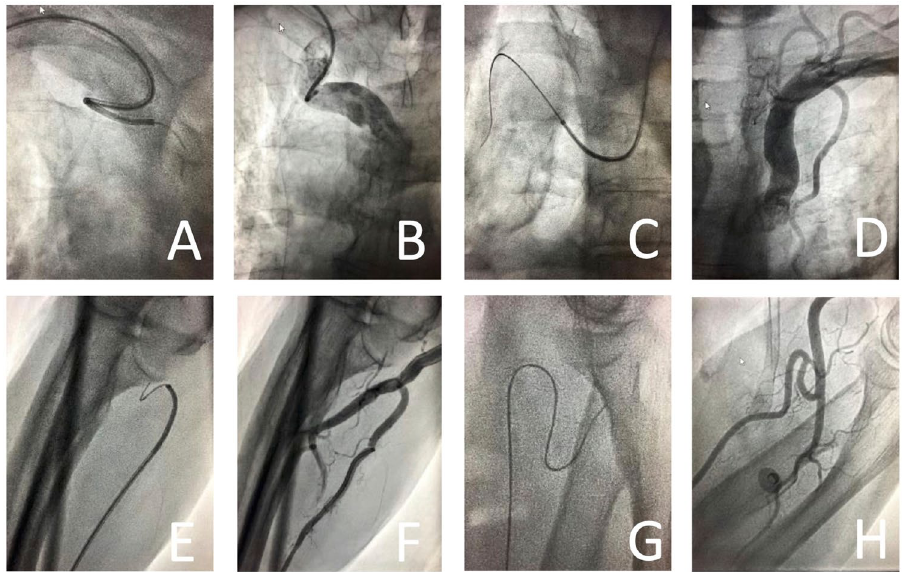
Figure 1. Representative fluoroscopies and angiographies of 2nd degree DVA encountered at our institution within the study period. The figures shown display vascular variants which could not be passed with any of the following guidewires, therefore meeting the definition of 2nd degree DVA: 0.035 ″ J guidewire (Angiodyn, B. Braun), hydrophilic 0.035 ″ guidewire (Radifocus Guidewire M, Terumo) and 0.018 ″ guidewire (Advantage, Terumo). ( A,B ) Severe tortuosity of the innominate artery in a 72-year-old female with suspected CAD. ( C,D ) Aortic arch elongation in a 77-year-old male presenting with NSTEMI. ( E,F ) Right radioulnar loop in a 87-year- old male with suspected CAD. The radioulnar loop became evident only after changing to a RAO 30° projection. ( G,H ) Severe tortuosity of the left radial artery in a 85-year-old female with NSTEMI. DVA difficult vascular anatomy, CAD coronary artery disease, NSTEMI non-ST-elevation myocardial infarction, RAO right anterior oblique.